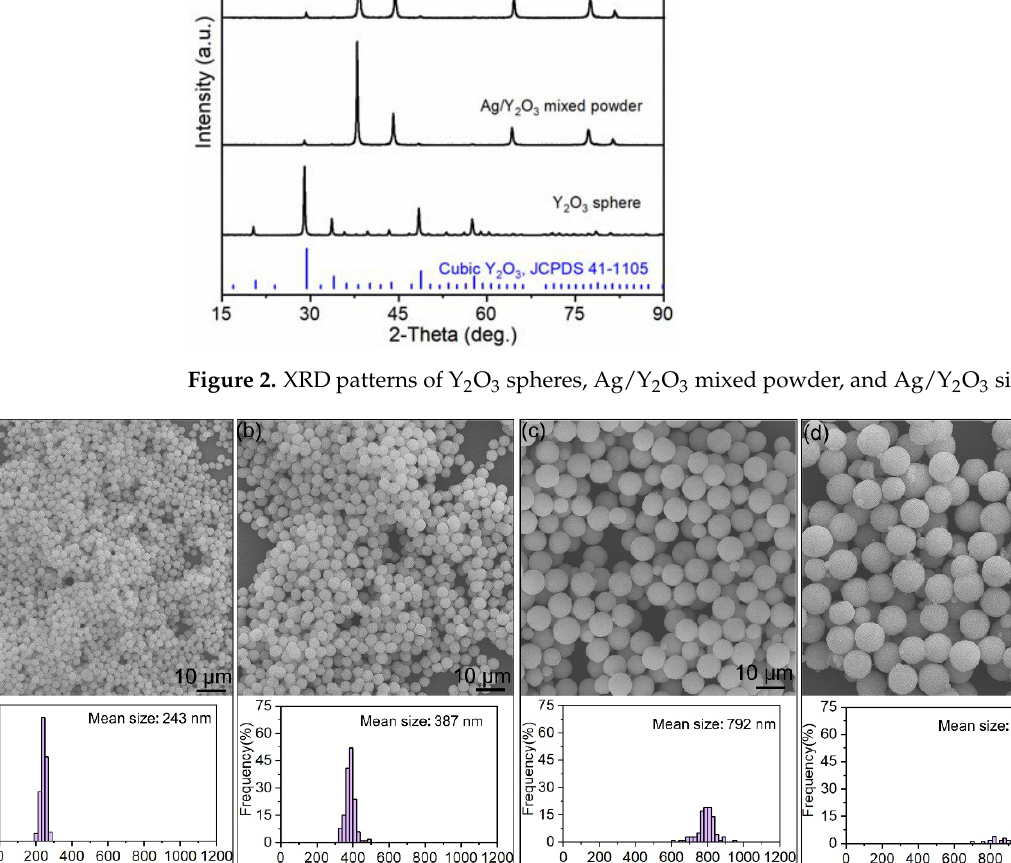
Figure 2. XRD patterns of Y 2 O 3 spheres, Ag/Y 2 O 3 mixed powder, and Ag/Y 2 O 3 sintered body.